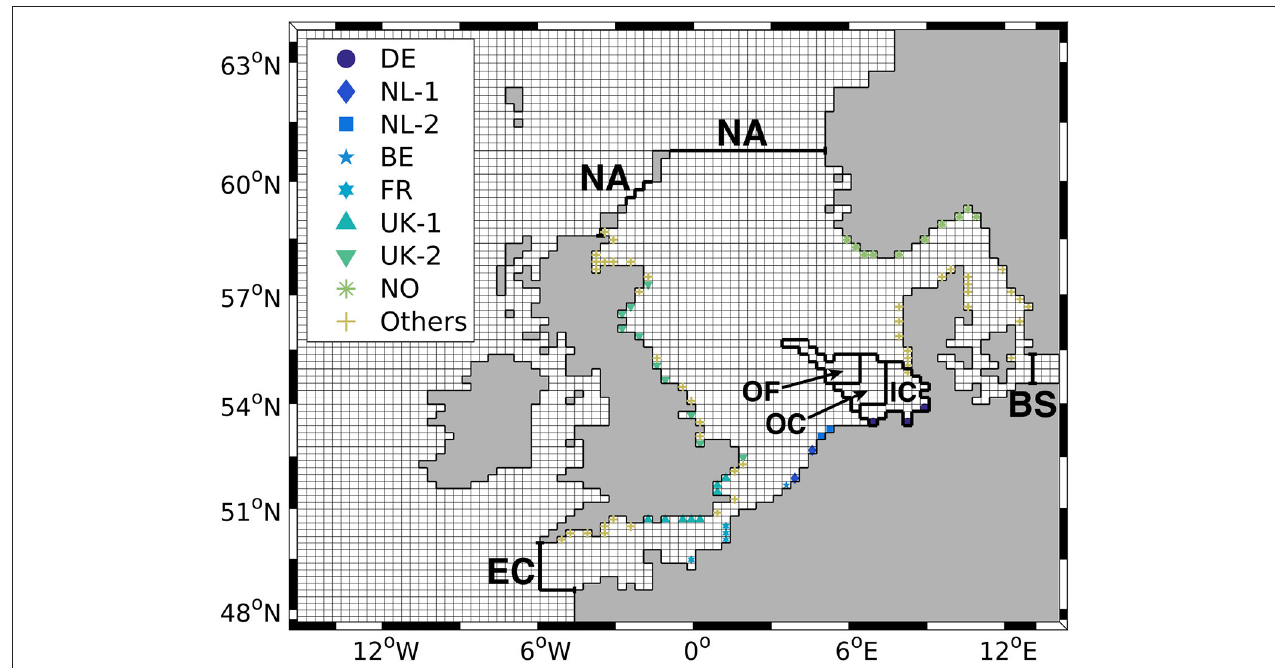
FIGURE 1 | ECOHAM model grid and TBNT sub-domain defined by the three outer boundaries: North Atlantic (NA), English Channel (EC), and Baltic Sea (BS). The different markers indicate the different river groups: German (DE), Dutch (NL-1/NL-2), Belgian (BE), French (FR), British (UK-1/UK-2), Norwegian (NO) and other rivers (“Others”). The sub-regions of the German EEZ used for analysis are: “Inner Coastal (IC),” “Outer Coastal (OC),” and “Offshore (OF).” Adapted from Große et al. (2017), with permission of the copyright holders.